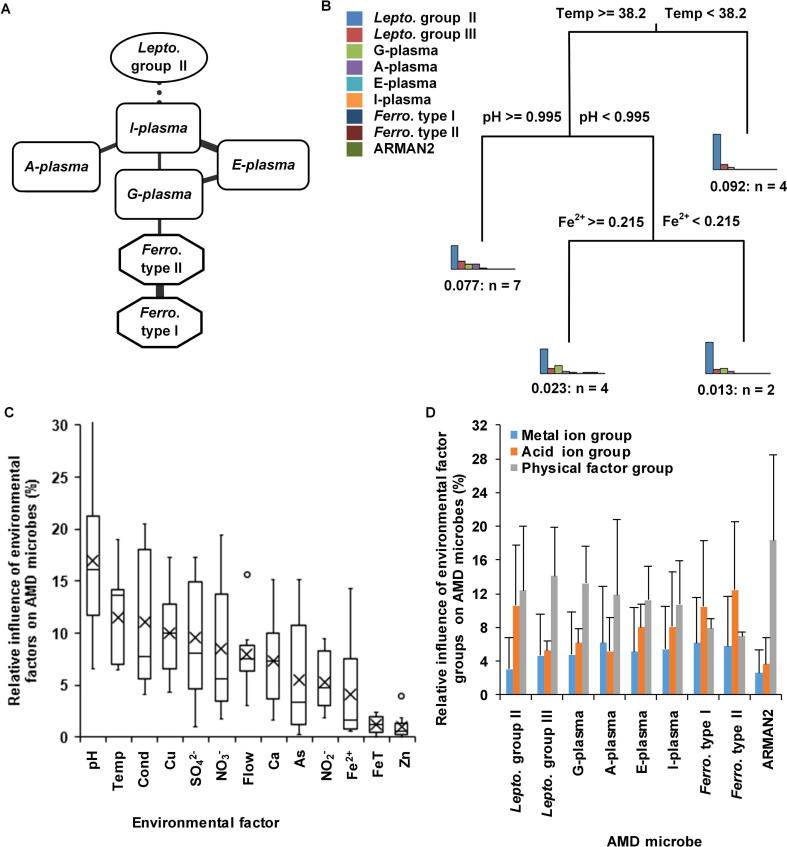
Relationships between relative abundances of microorganisms and environmental factors in AMD samplesA. Social relationship network in AMD biosystem. Only statistically significant edges (P < 0.05, after Bonferroni correction, correlation coefficient ≥0.65) were retained. Dotted lines reflect negative relationship between different microbes and solid lines represent positive ones. The thicker lines indicate higher correlation coefficients, i.e., stronger relationships between microorganisms. B. Relationships between community structure and environmental factors in AMD samples with MRT model. C. Relative influence of environmental factors on microorganisms using GBM method. The circles represent the outlier values and black crosses show the mean influence of the corresponding environmental factors on microorganisms. D. Relative influence of environmental factor groups on microorganisms. Environmental factors are divided into three groups: physical factor group (pH, temperature, flow, and conductivity), acid ion group (SO42−, NO3–, and NO2–), and metal ion group (Fe2+, FeT, Zn2+, Cu2+, As3+, and Ca2+). Relative effects of each group on microorganisms calculated using GBM models are presented. MRT, multivariate regression tree; GBM, gradient boosting machine.